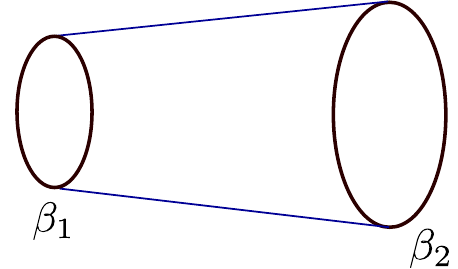
Figure 4. Euclidean picture of the two quantum dots living on the thermal circles of different lengths coupled by the conical